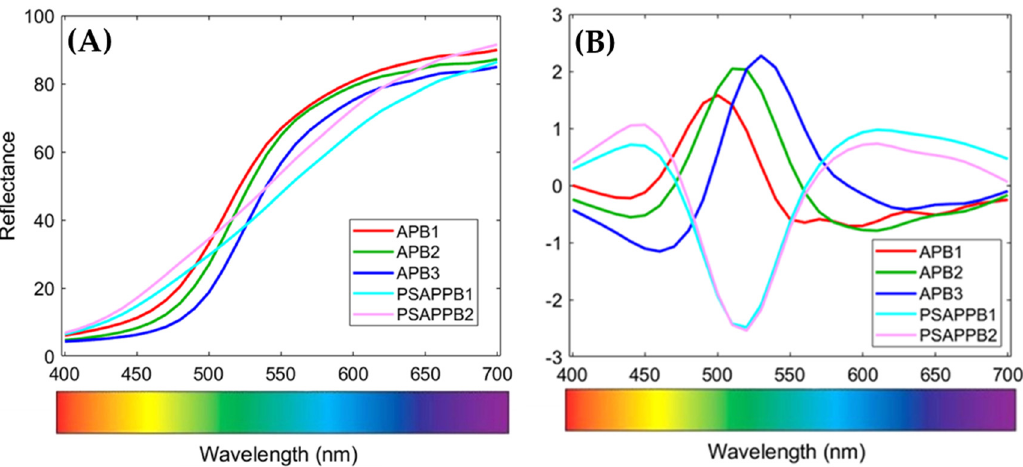
Figure 6. Reflectance spectra of artificial Pb/Sb yellows ( A ) and pre-processed spectra ( B ) through MSC (Median), 1st Derivative (order: 2, window: 5 pt, including only tails: weighted), Mean Centre.